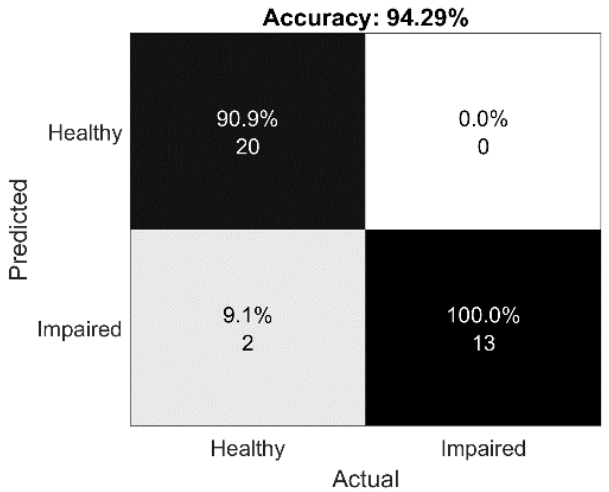
Figure 5. Confusion matrix of the E3 classification on 35 samples on a test set (20 correctly classified records (target class = 0), 13 correctly classified test records (target class = 1), 0 incorrectly classified instances (target class = 0), and 2 incorrectly classified instances (target class = 1)) using a bidirectional long short-term memory (BiLSTM) network and majority vote